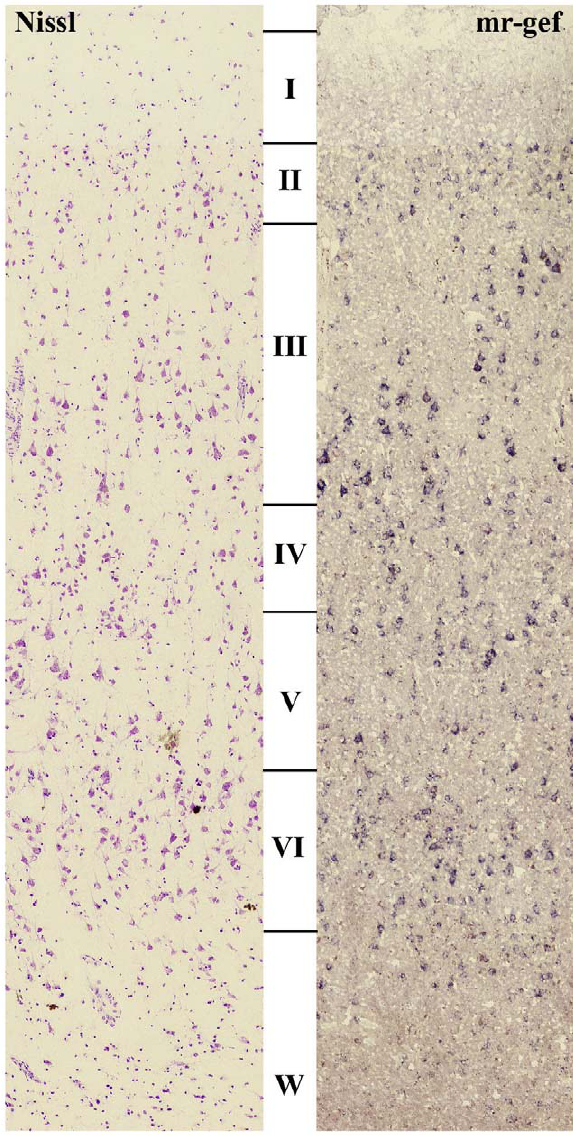
Figure 2. MR-GEF labelled and Nissl stained sections. Compar- ison of Nissl stained and MR-GEF labelled serial sections showing that MR-GEF is expressed by cells throughout the cortex and is not confined to GABAergic